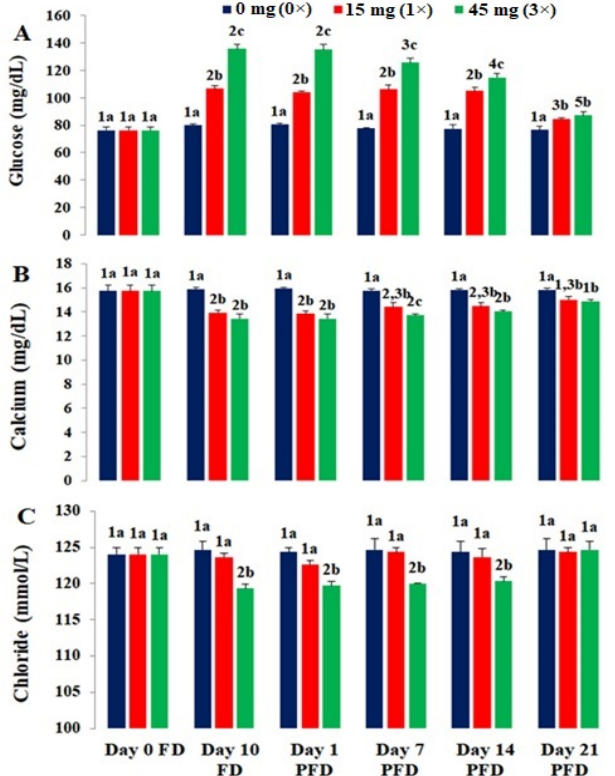
Figure 2. Effects of florfenicol (FFC) dosing at 0–3 times the therapeutic dose of 15 mg kg biomass − 1 day − 1 for 10 consecutive days on the serum ( A ) glucose, ( B ) calcium, and ( C ) chloride levels of Oreochromis niloticus juveniles. a–c: bars sharing a common alphabet for a particular day differed insignificantly ( p > 0.05). 1–5: bars sharing a common numerical for a particular treatment (dose) differed insignificantly ( p > 0.05).